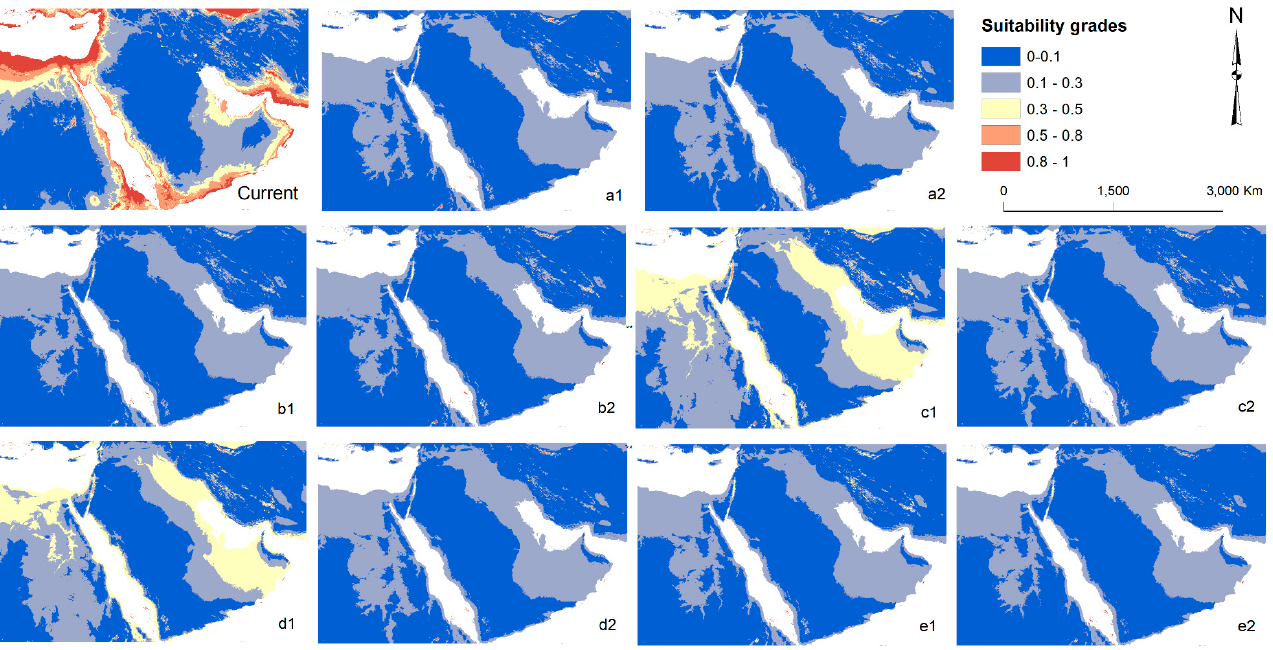
Figure 2. Occurrence records and potentially suitable climatic distribution of Spogostylum ocyale in Egypt and some Middle Eastern countries.